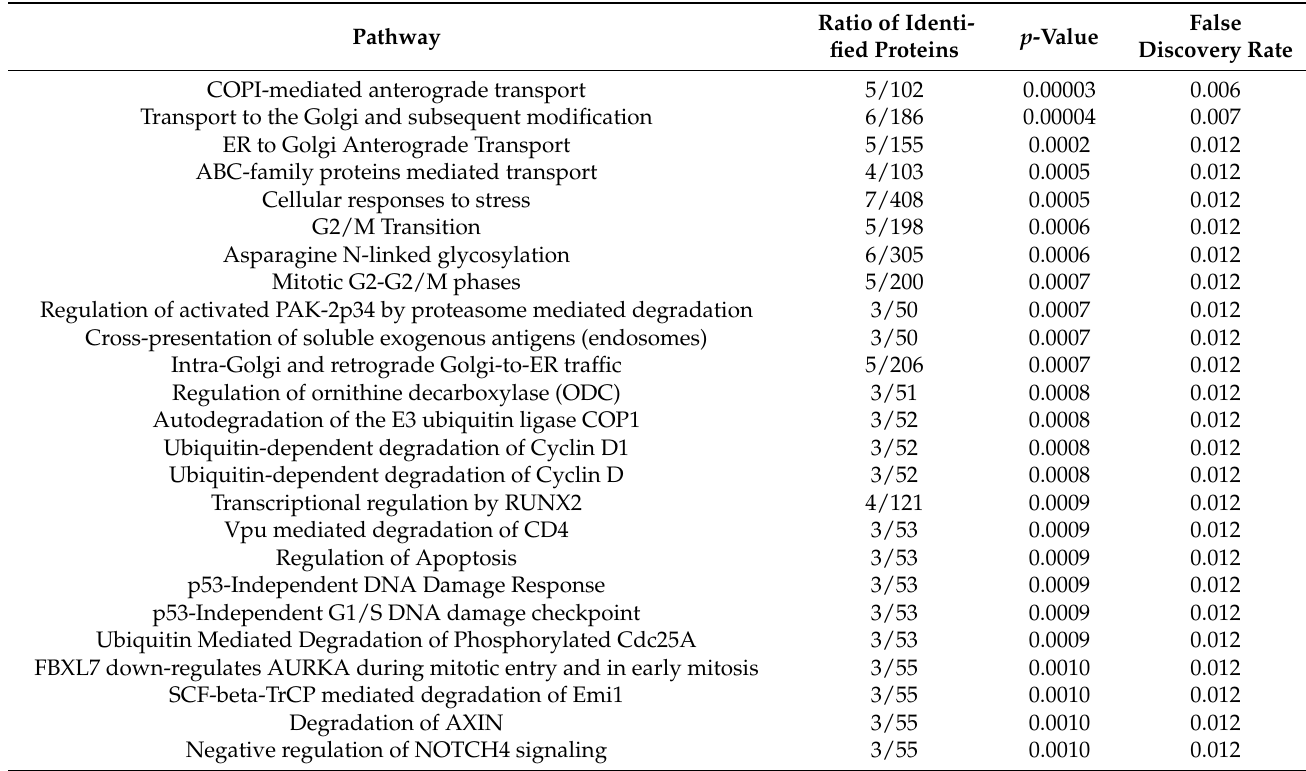
Table 4. Pathway analysis of most relevant proteins of the OAB group (ranked according to the p -value of the enrichment analysis of the Reactome Pathway Analysis of the OAB group; modified after Fabregat et al. [23]).